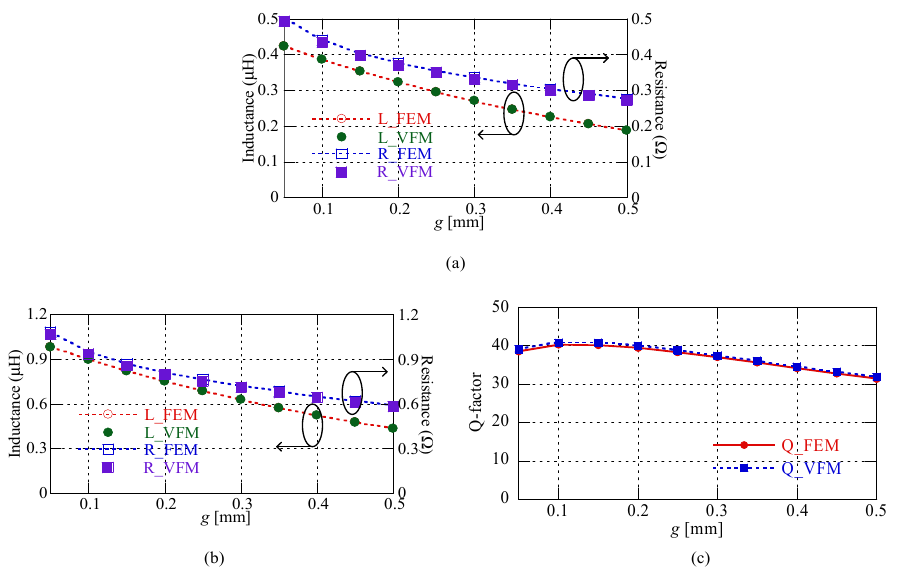
Figure 6. The calculations and simulations of resistance and inductance according to g for ( a ) double-layer and ( b ) four-layer planar spiral coils with N = 4. ( c ) Q-factor for the four-layer planar spiral coil.